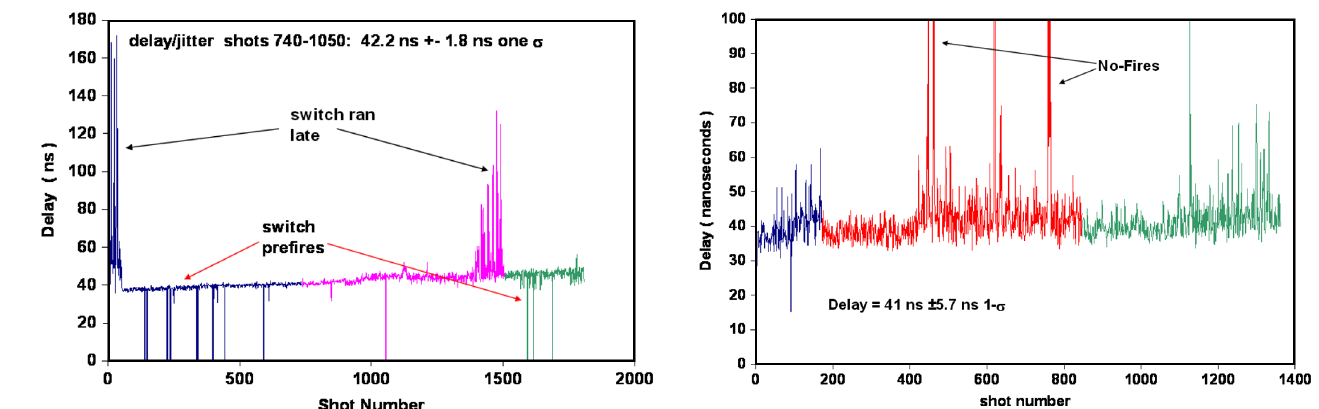
FIG. 15. (Color) Lifetime test results for the Russian switch at a (cid:2) 100 kV charge voltage. The switch was operating at 67% of the switch’s self-breakdown voltage. The data was taken on three successive days as indicated by the color coding of the